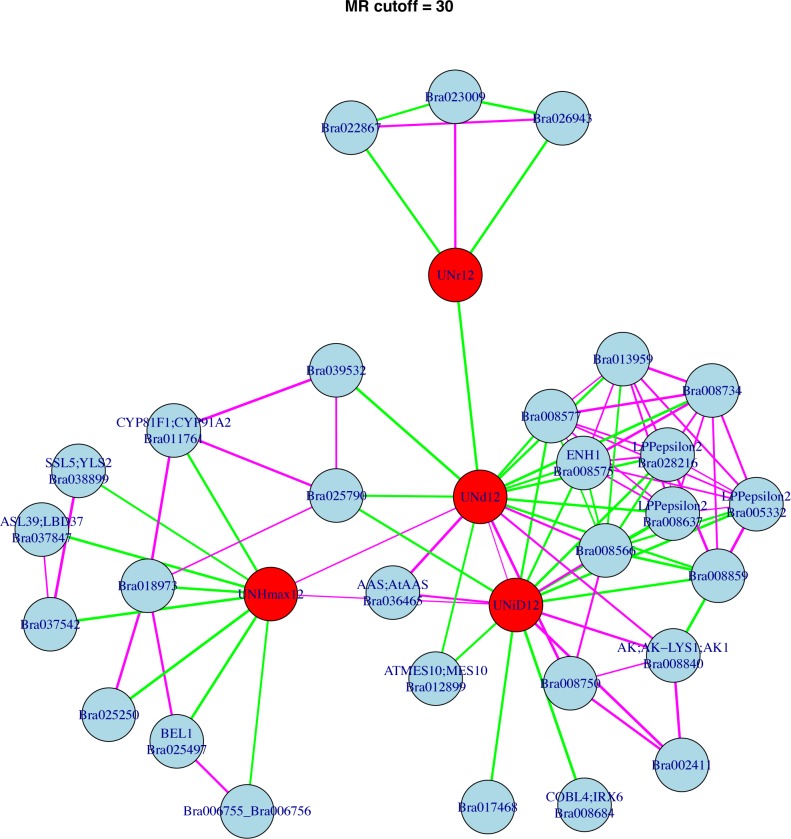
A scale-free diagram of the Mutual Rank network nucleated around FVT traits from 2012 with a cutoff of 30.Network nodes consist of either FVT traits or co-expressed genes. FVT traits are shown in red circles and genes are indicated in blue circles. Network edges indicate significant correlations. Purple lines indicate positive correlation values while green lines indicate negative correlation values and line thickness corresponds to strength of the correlation. UN, uncrowded; r, growth rate; d, duration of growth; iD, time in degree days when the growth curve reached its inflection point; Hmax, estimated maximum height based on FVT modeling. Additional network cutoffs, 2011, and 2012 crowded networks are in S4 Fig; gene names and annotations are in S3 Table.